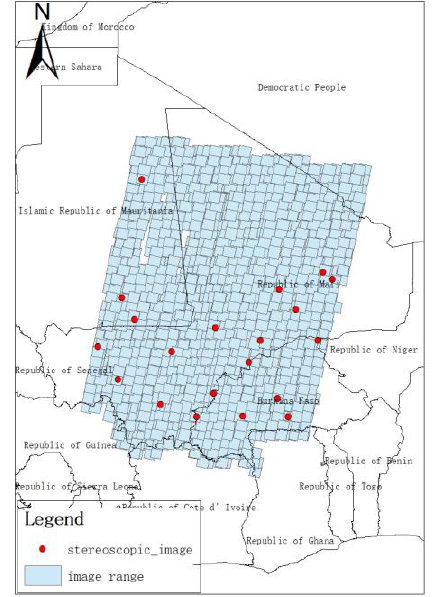
Figure 1. Image distribution of high-resolution satellites in North-West Africa